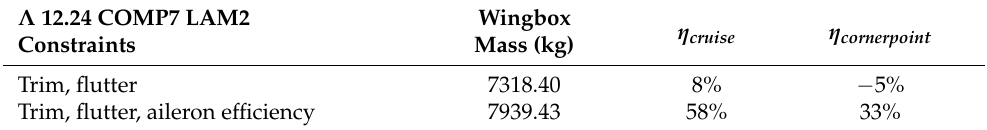
Wingbox η cruise η cornerpoint Mass (kg)